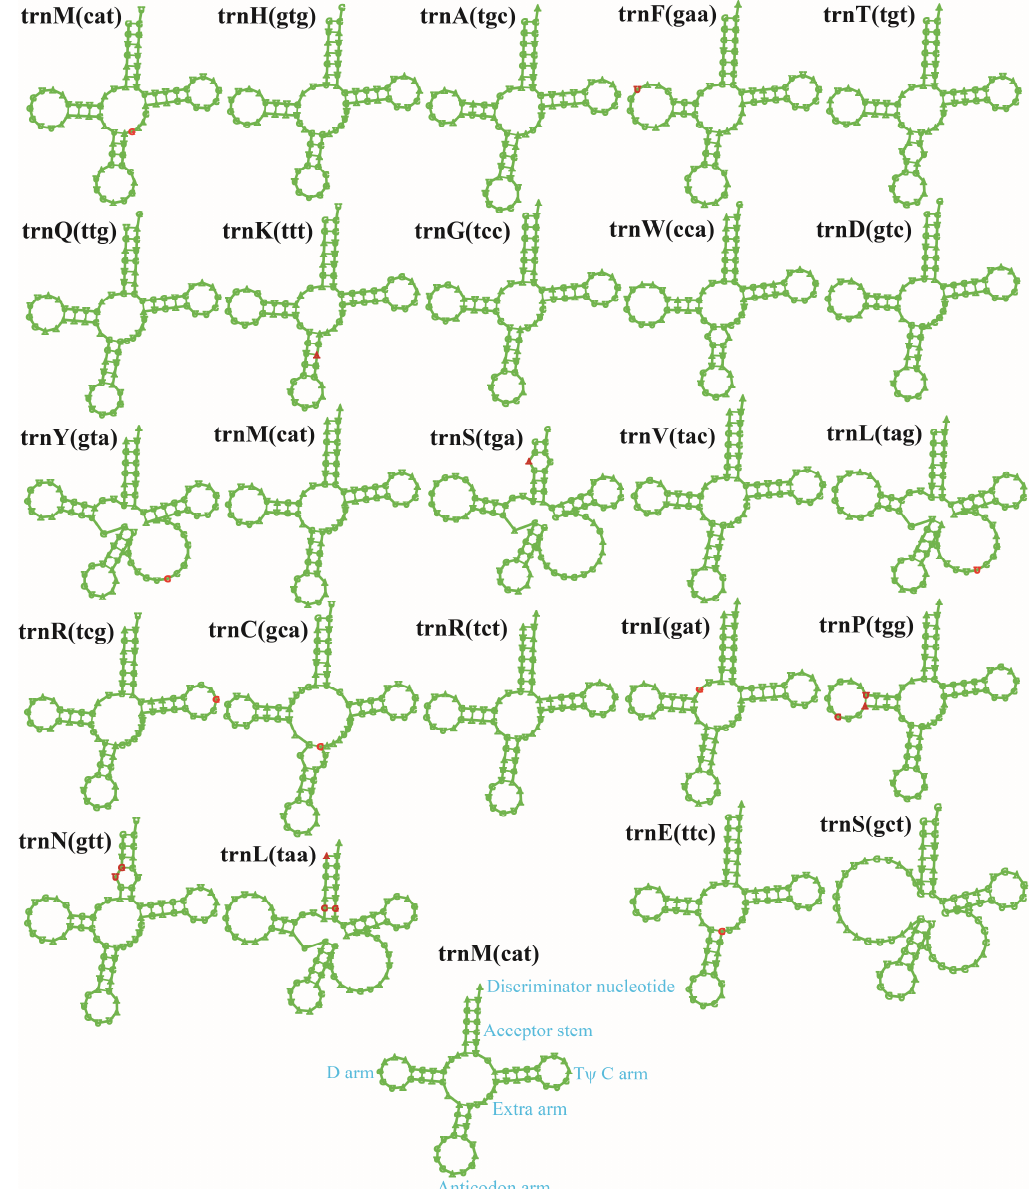
Figure 2. Putative secondary structures of the 25 tRNA genes identified in the mitogenomes of two Rhizopogon species. Residues conserved across the two mitogenomes are shown in green, while variable sites are shown in red. All genes are shown in order of occurrence in the mitogenome of R. salebrosus , starting from trnM .